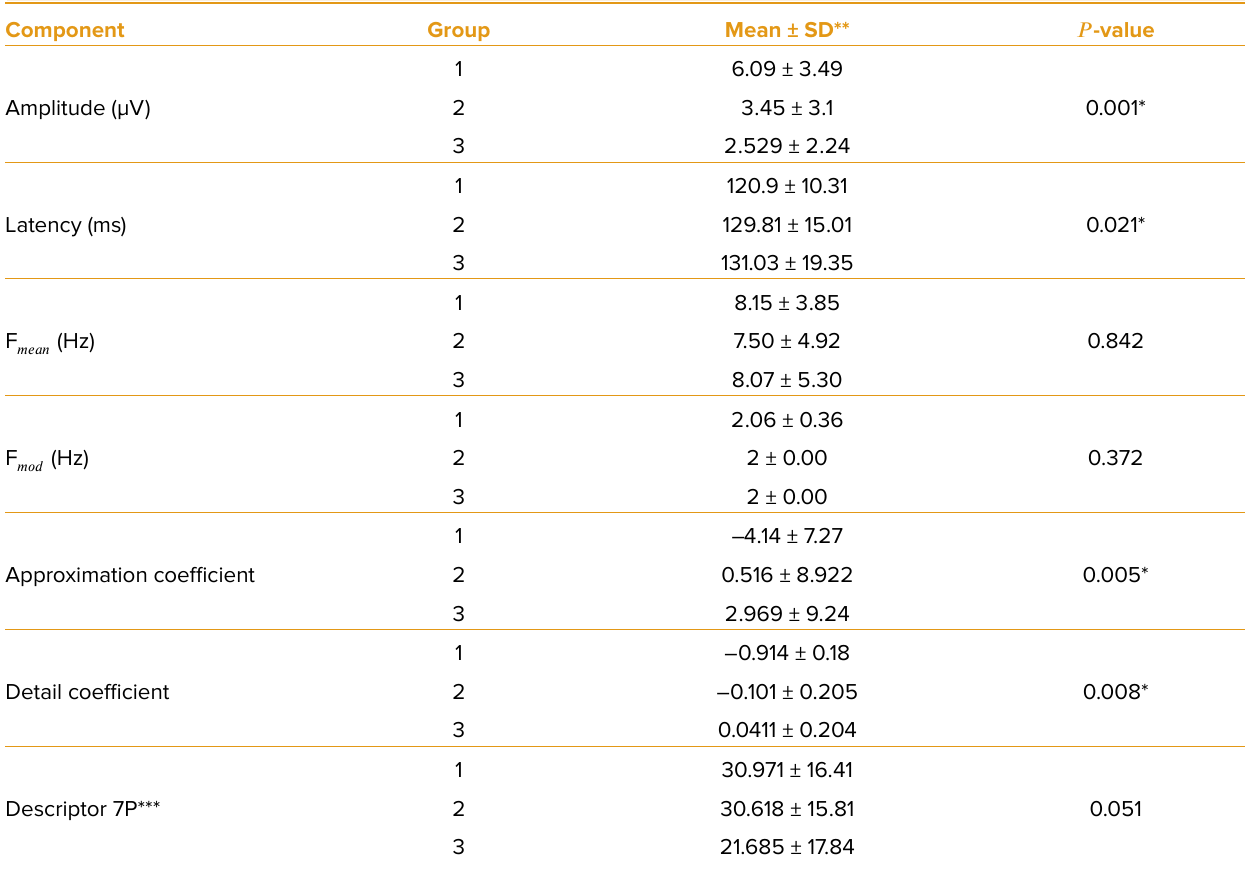
Table 1. Results of one-way analysis of variance (ANOVA) for three groups of spatial frequency